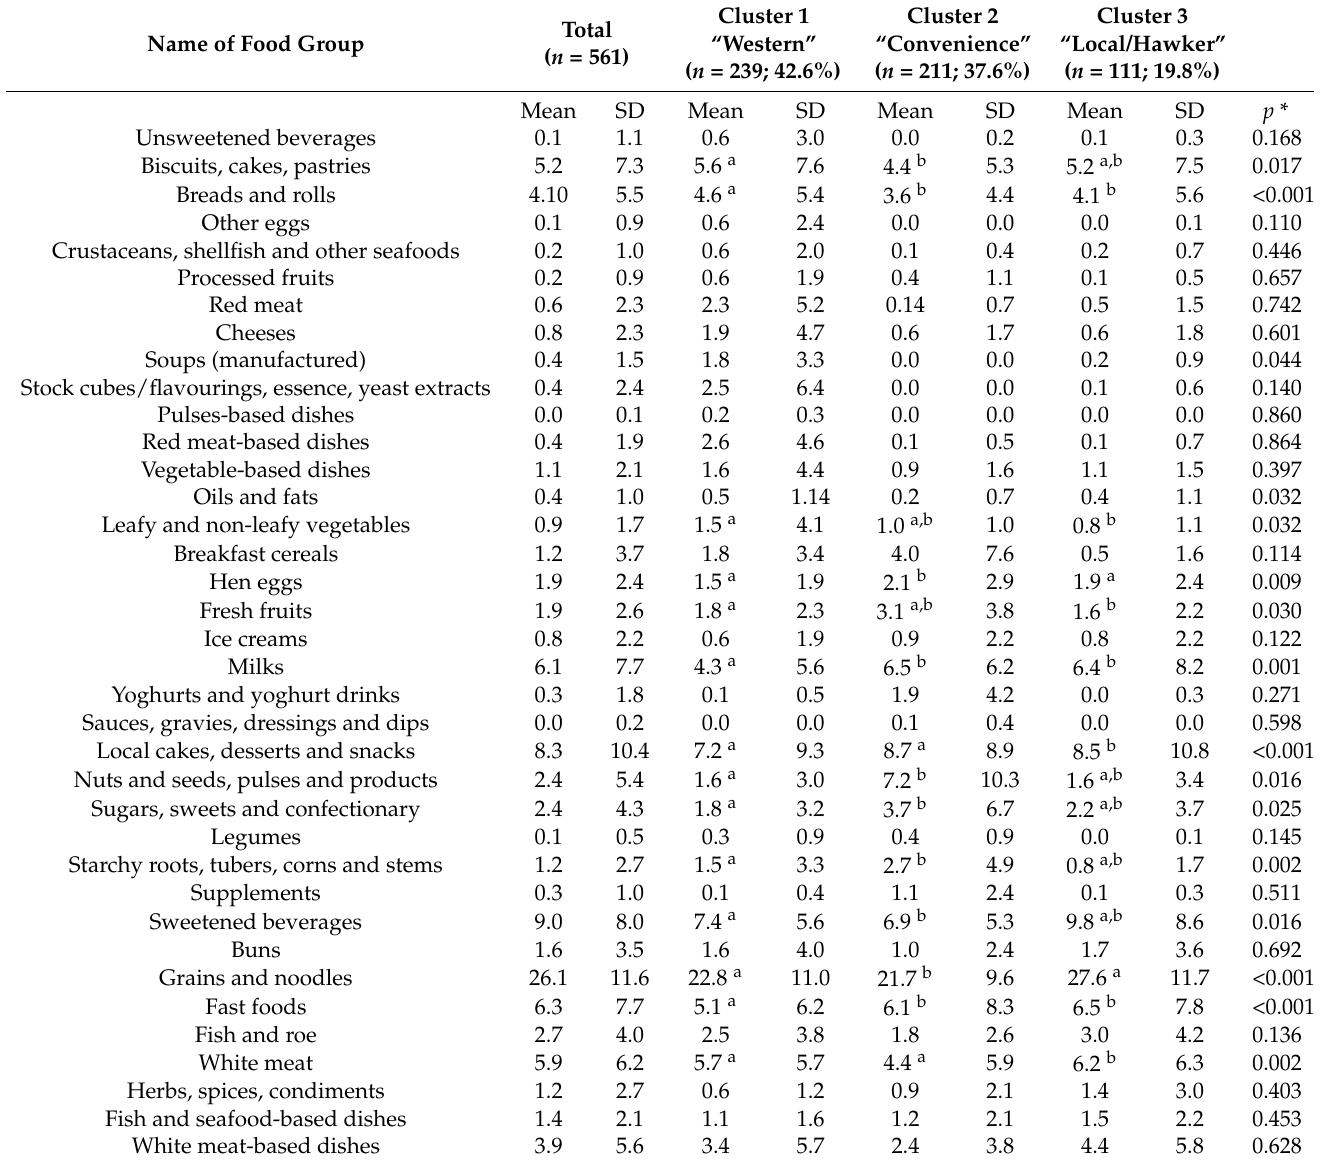
Table 1. The percentage of energy contribution of food groups across three dietary patterns in young Singaporean children.